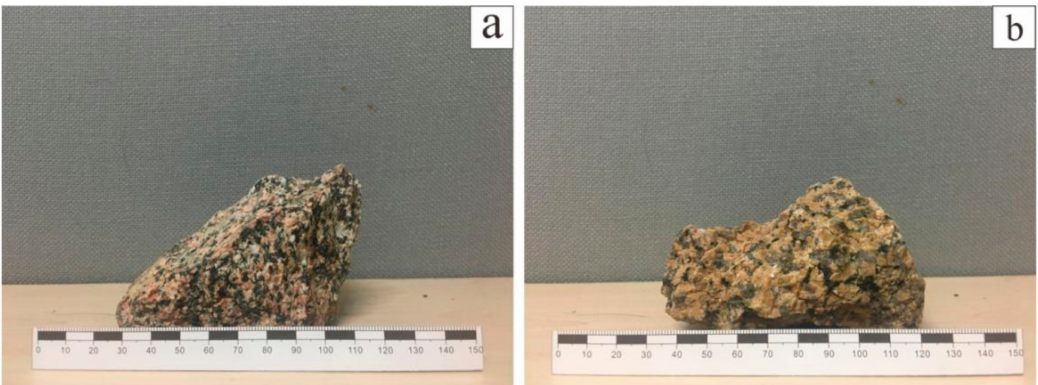
Figure 3. Photographs of the studied granitoids in the hand specimen: ( a ) the Hongshan pluton, ( b ) the North-Karamay